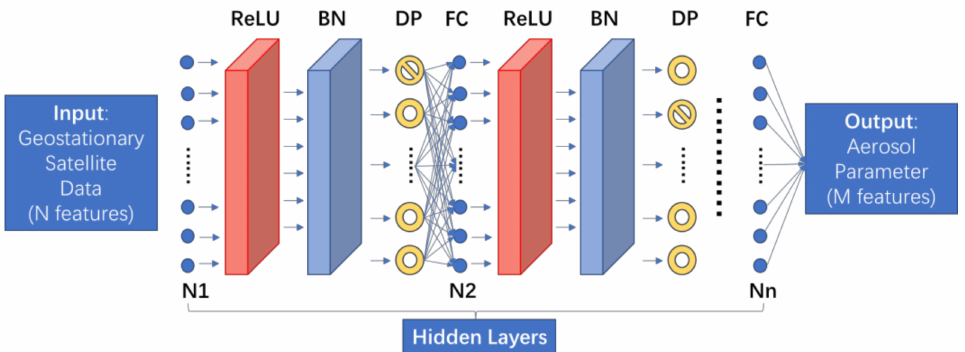
Figure 3. Architecture of the neural network for NNAeroG. ReLU is the activation layer. BN is a batch normalization layer. DP is the dropout layer. FC is the full connected layer. The input vector possessed N features, and the number of output features M could be 1, 2, or 3. For Himawari-8/AHI aerosol retrieval, the M is 1 which, means that every aerosol parameter possessed a special NNM. Nn is the neutron number of every FC layer, which could be